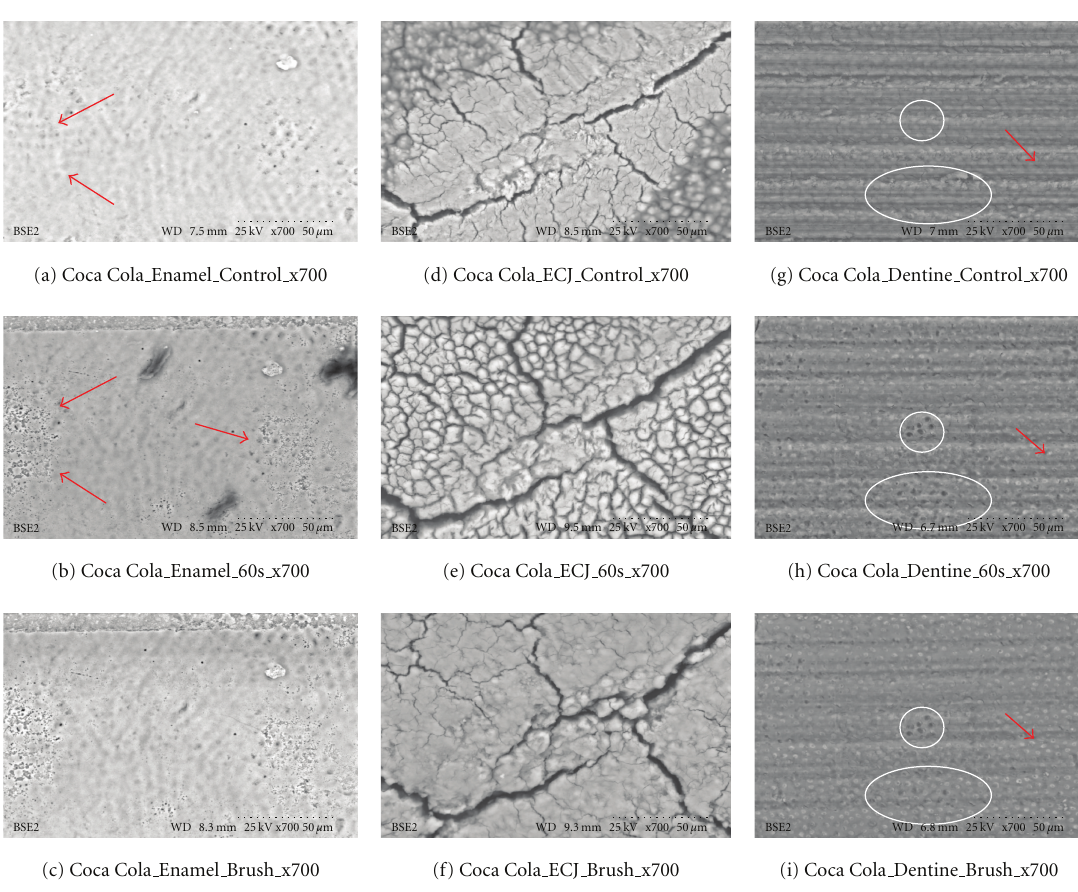
Figure 6: Coca Cola ( × 700). (a–c) The red arrows show developing erosive e ff ects on smear layer over the surface of enamel; there is enamel erosion and minor abrasion as enamel is dense and hard. (d–f) show developing cracks and crevices over the ECJ surface which become aggravated due to loss of calcium. Also abrasion as loss of material after brushing, with the softened surface reflecting loss of detail going down to deeper more calcified layers, is seen in (f) compared to (e). Red arrow in (g) shows closed dentine tubules which are markedly opened in (h) after exposure to the cola. (i) shows loss of surface material, removed by abrasion, with some tubules (circled) becoming smaller, while others (red arrow) expose deeper levels of the tubes. These results correlate well with the calcium measured in expectorates from swishes with Coca cola in Figure